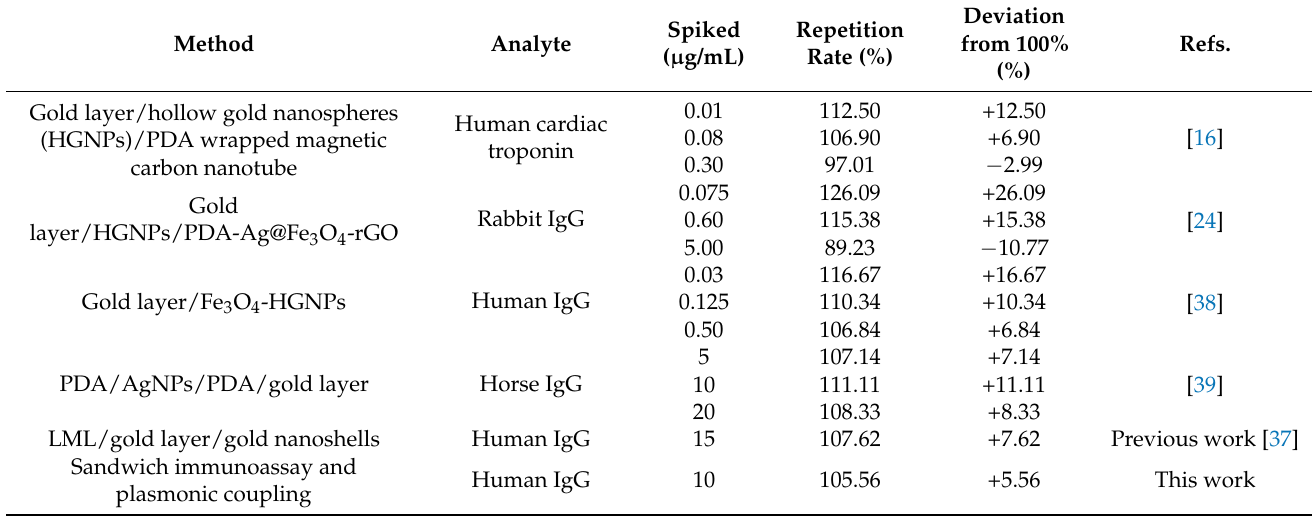
Table 3. Comparison between the repetition rate in this paper and those reported